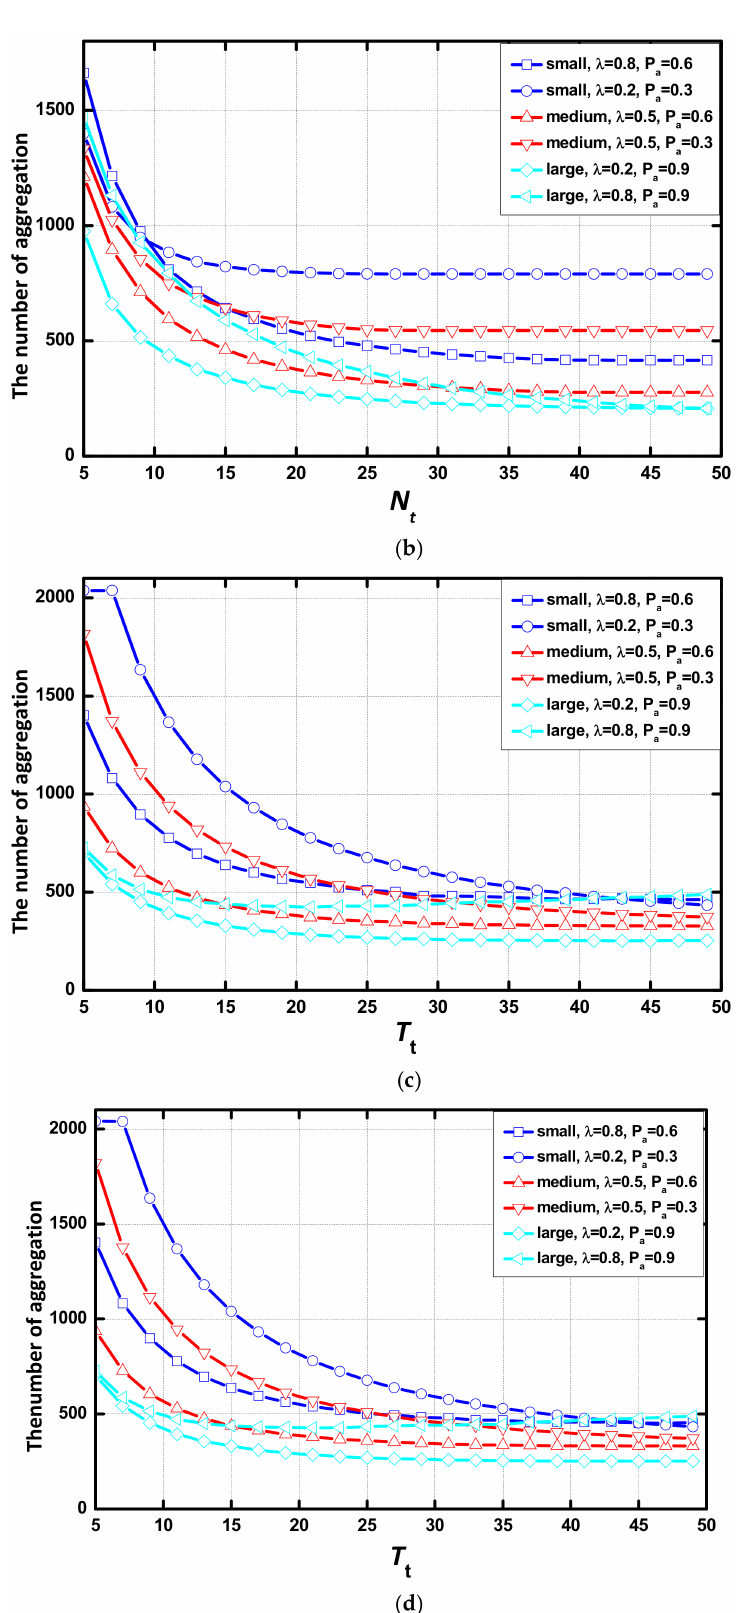
Figure 11. Number of aggregations vs. N t or T t in different environments ( a ) Common scheme, vs. N t ; ( b ) AAR scheme, vs. N t ; ( c ) Common scheme, vs. T t ; ( d ) AAR scheme, vs. T t